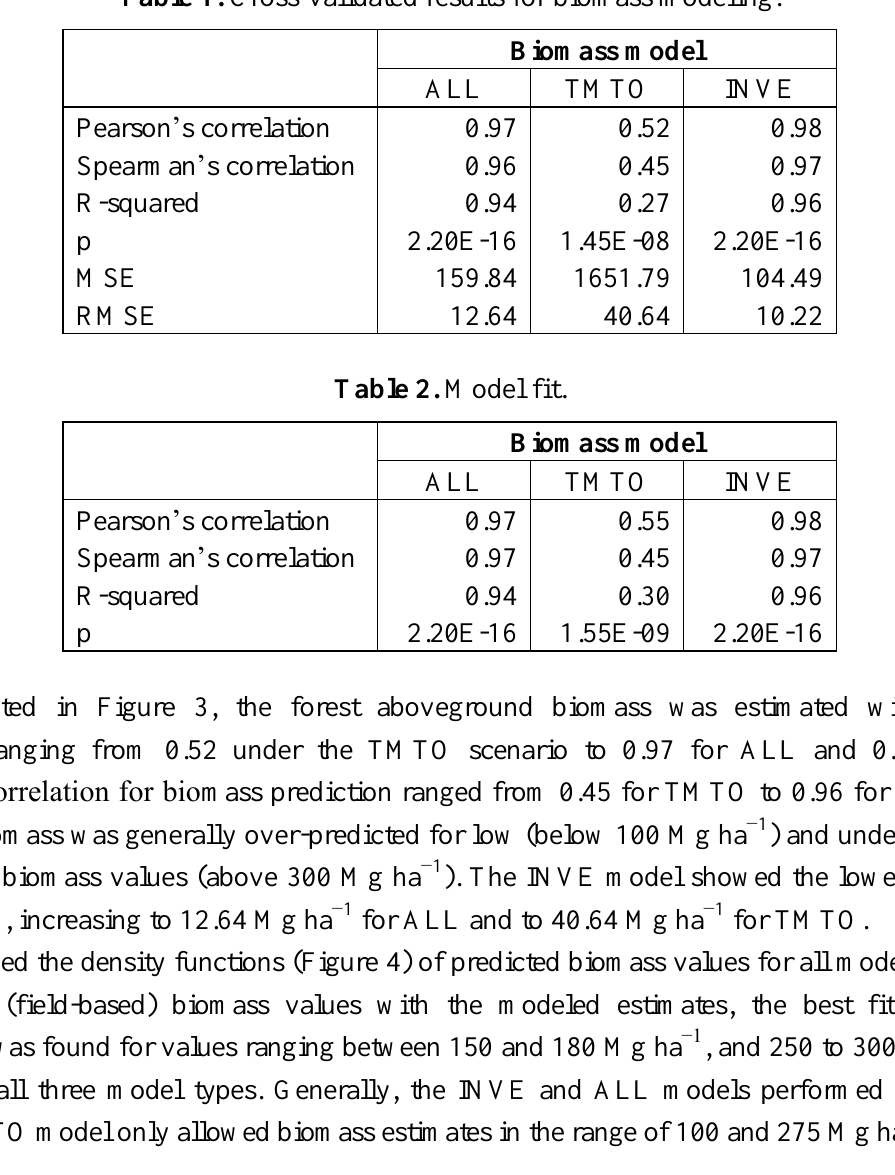
Table 1. Cross-validated results for biomass modeling.